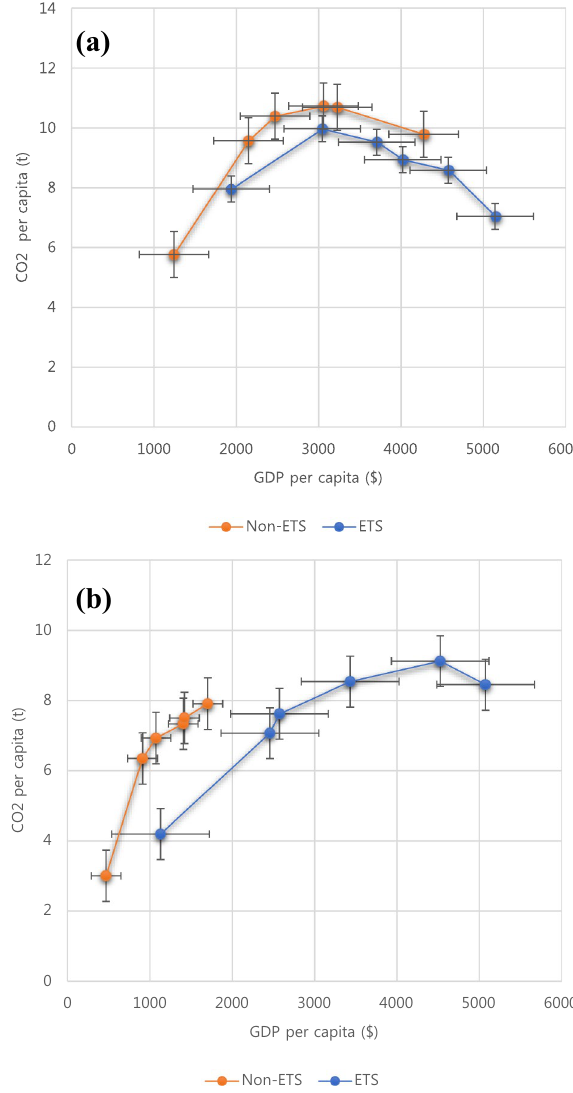
Figure 3. Environmental Kuznets curve (EKC) of decoupled and non-decopled countries classified by emission trading scheme (ETS) participation status and grouped at decade level. ( a ) Decoupled countries; ( b ) non- decoupled countries. GDP, gross domestic